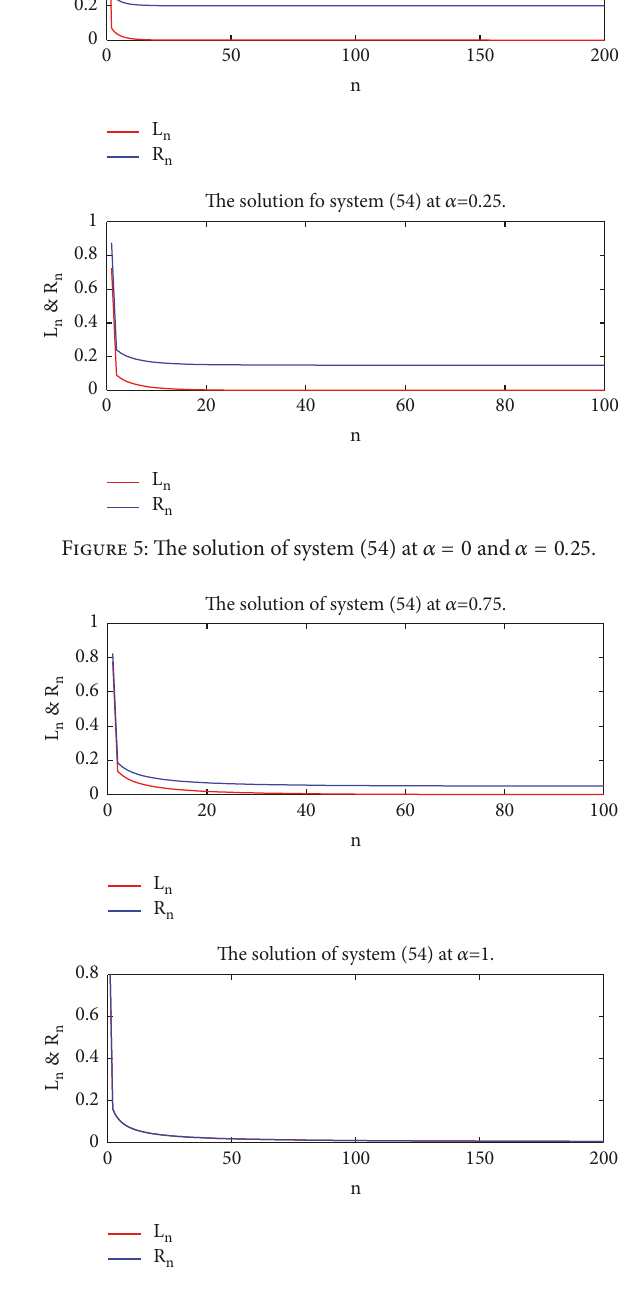
Figure 6: The solution of system (54) at 𝛼 = 0.75 and 𝛼 =